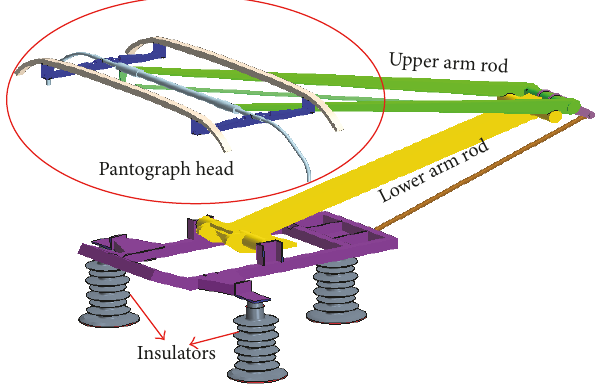
Figure 1: Geometric model of pantographs in high-speed